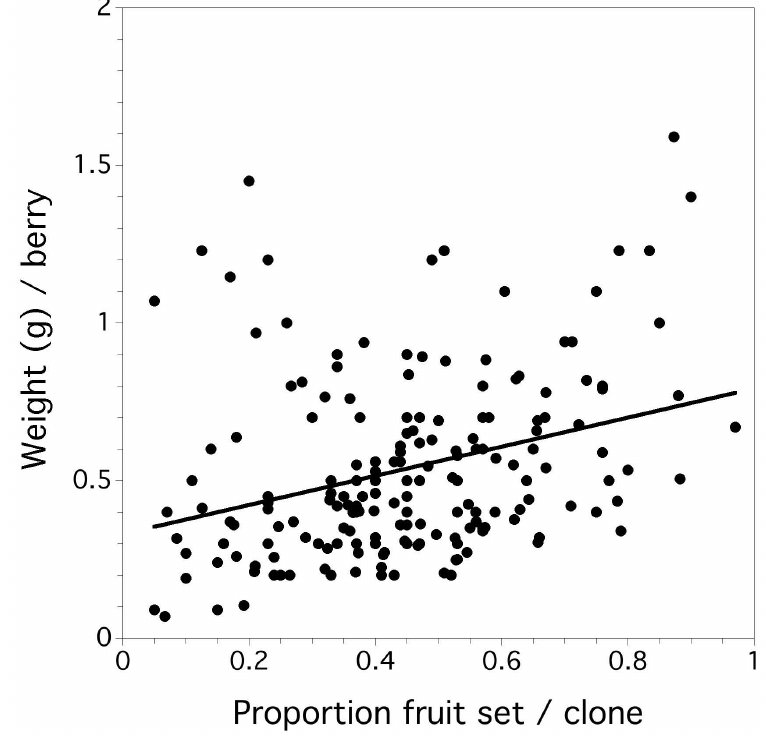
Figure 3. The linear relationship between proportion fruit set in a clone and resulting berry weight over all four